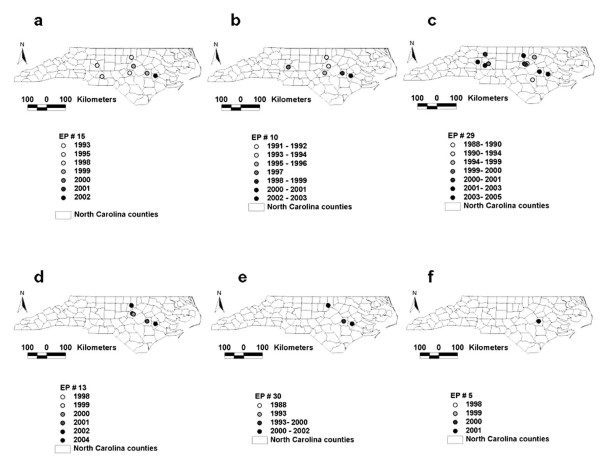
Spatial diffusion profiles of S. aureus subspecies (EPs). High (large) spatial and high (faster) temporal diffusion (a, and b), high spatial and low (slower) temporal diffusion (c), low (small) spatial and low temporal diffusion (d), low spatial and low temporal diffusion (e), and local (not spatial), although frequent, diffusion (f). Maps display only the most recent observation on a given farm (previous observations on the same location may have occurred).